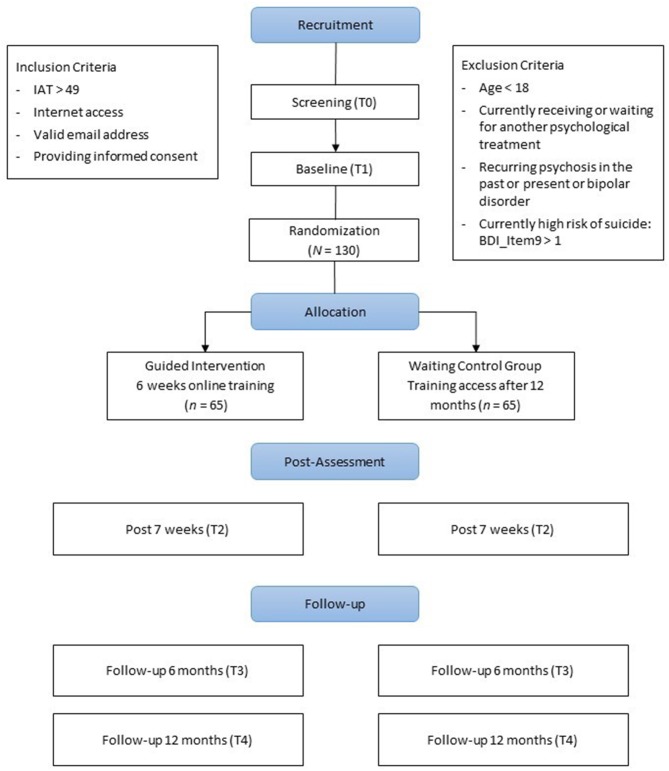
Study flow chart.